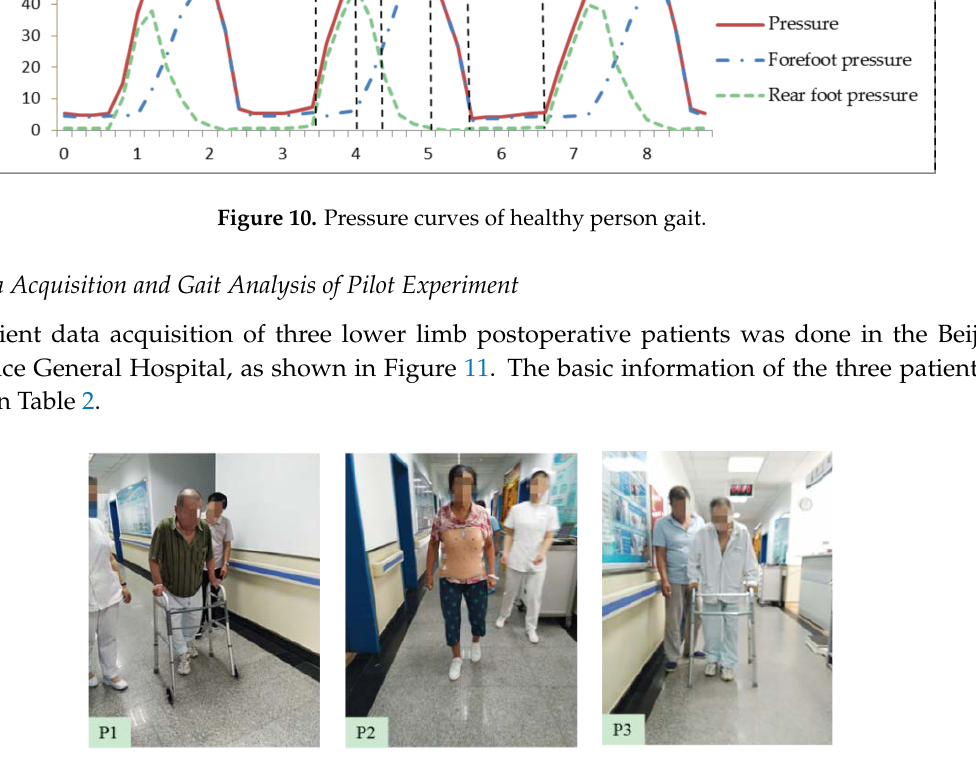
Figure 11. Photographs of the clinical trial.